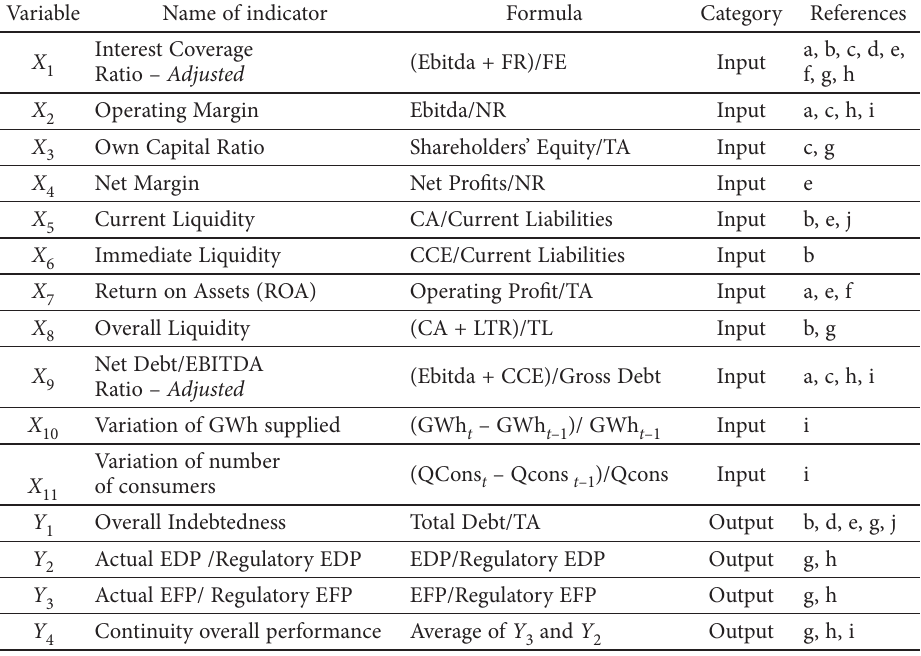
Table 2. List of indicators for the analysis of ED